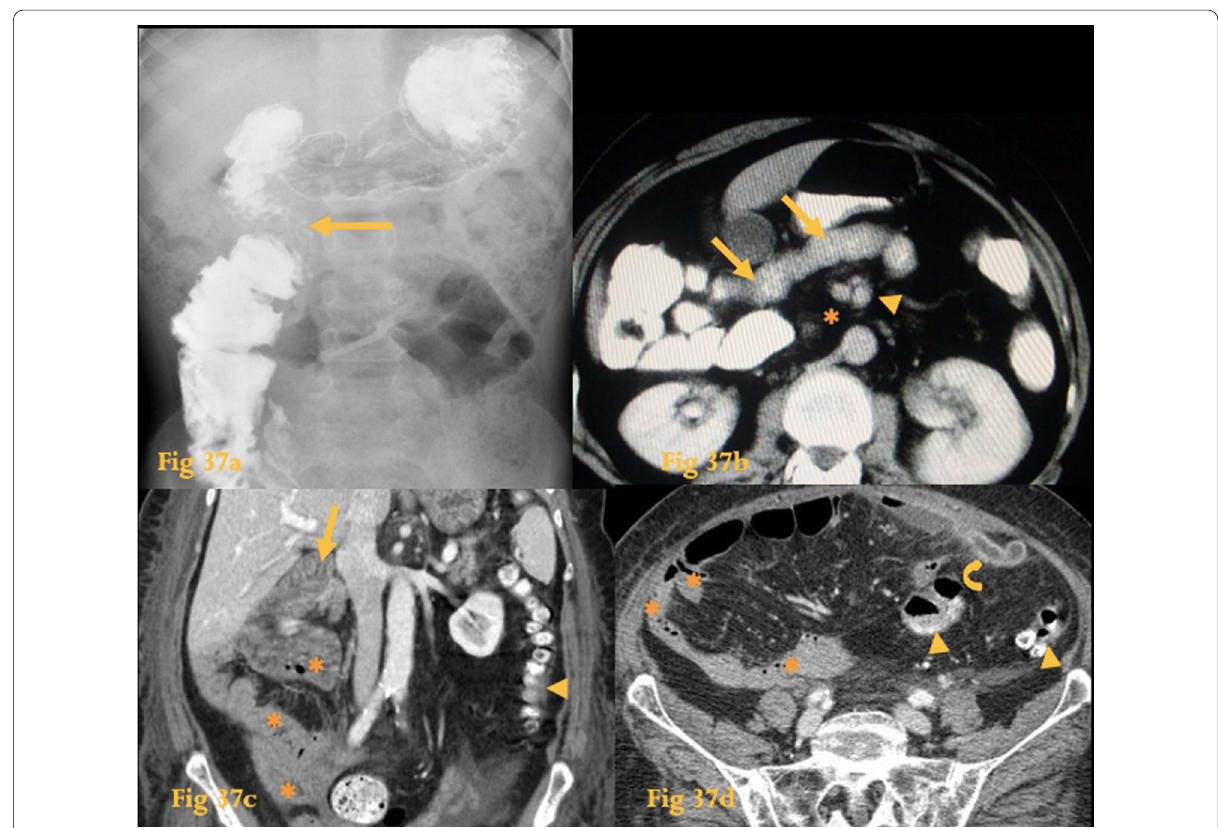
Fig. 37 Gut malrotation. Barium study of an 8‑year‑old ( a ) with intestinal malrotation shows that the duodenum does not cross the midline (arrow). Abdominal CT of an adult patient ( b ) reveals absence of the 2nd part of the duodenum between the aorta and SMA (asterisks). The duodenum (arrows) crosses anterior to the SM vessels, which show an inverted relationship, with the artery located on the right and the vein on the left side (arrowhead). Incidentally, this patient also had an abnormal course of the portal vein and absence of the inferior vena cava. Abdominal CT of another adult with left flank pain and fever ( c , d ) shows that the duodenum does not cross the midline (arrow). The small bowel is located predominantly on the right quadrants (asterisks) while the large bowel is located on the left quadrants (arrowheads). On the left flank, an enhancing and thickened, fluid‑filled tubular structure (curved arrow) is seen coming out of the cecal pole, which was located on the midline—this was a rare case of an appendicitis on the left quadrants in a patient with